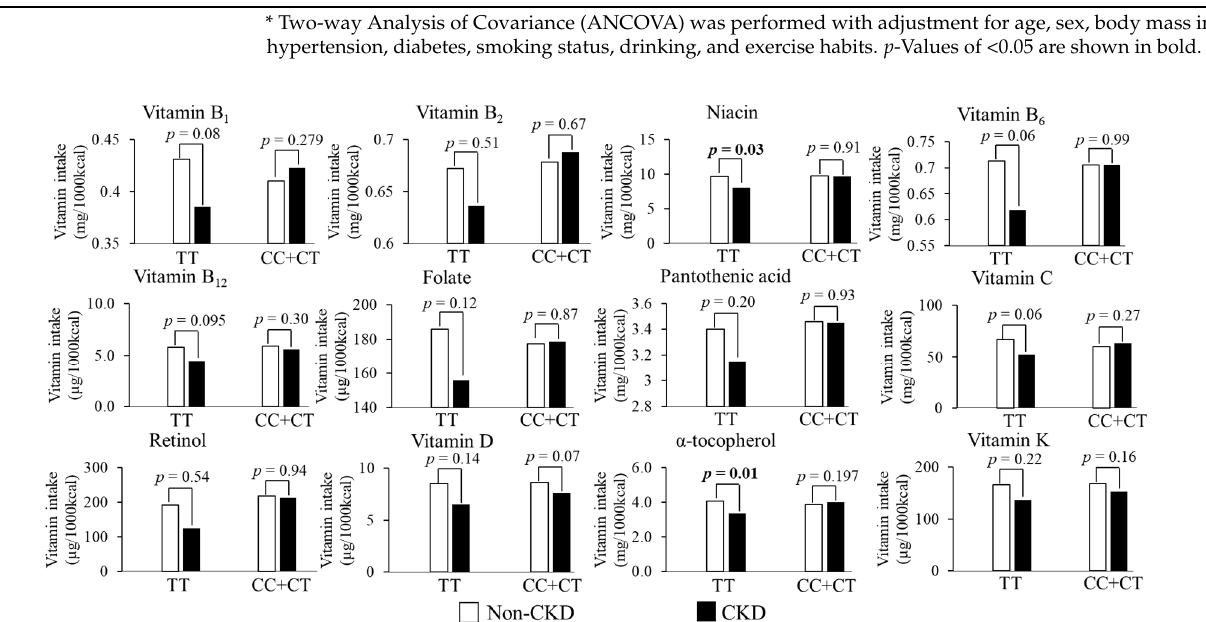
Figure 2. Interaction between vitamin intake and rs883484 genotype in the recessive model on CKD by two-way ANCOVA with adjustment for age, sex, BMI, hypertension, diabetes, smoking status, drinking, and exercise habits. p -Values were from the Bonferroni test.